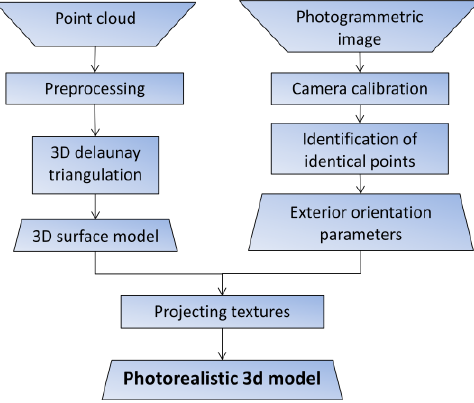
Figure 5. The concept of fusion CRP and